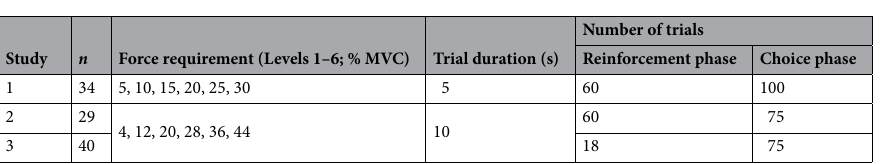
Table 1. Physical force requirements across the three pooled effort discounting